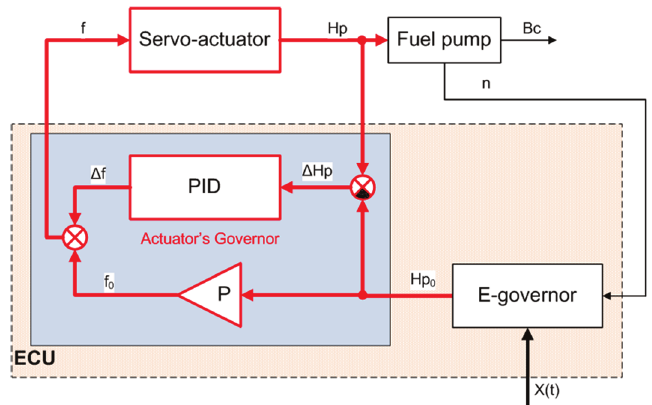
Fig. 1. Functional diagram of the electronic control system of a diesel engine